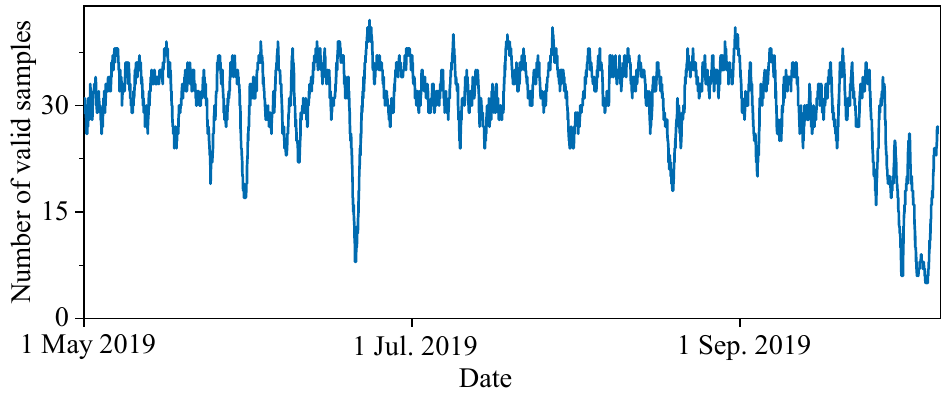
Figure 16. Missing data may make the PDI curve unstable. Figure 16. The number of valid samples per day. Figure 16. The number of valid samples per day.